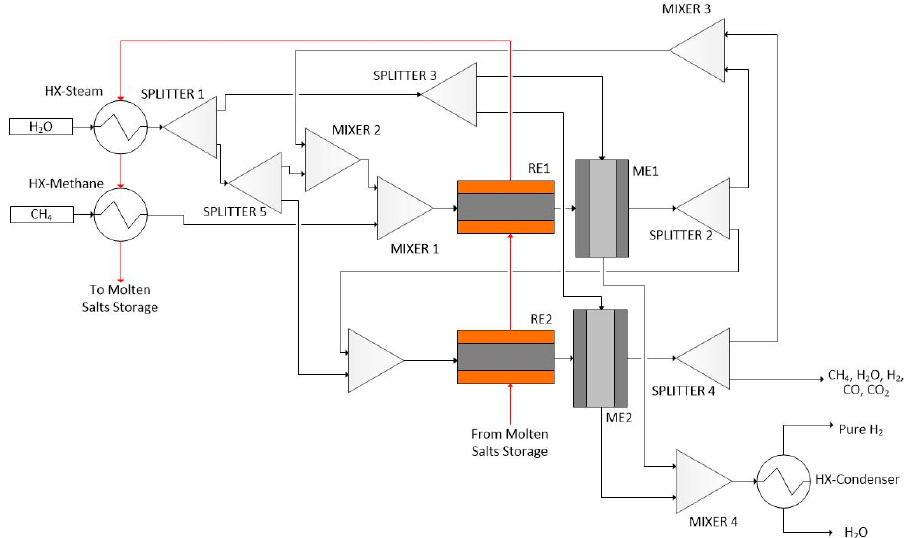
Figure 4. Cascaded multiple reactor-membrane flowsheet configuration (CRMRM).